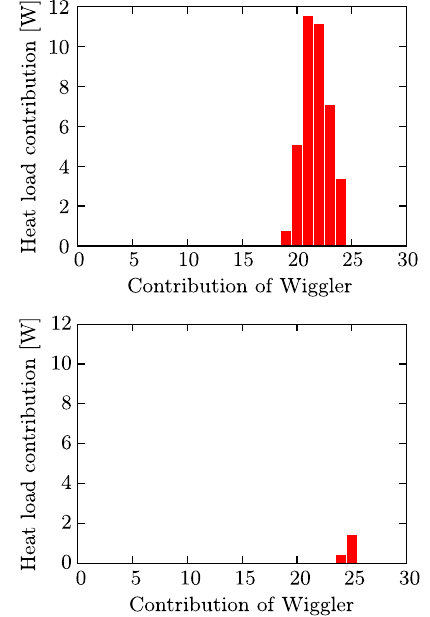
FIG. 13. Heat load on the 25th and 26th beam pipe of the wiggler magnets due to synchrotron radiation from upstream wiggler